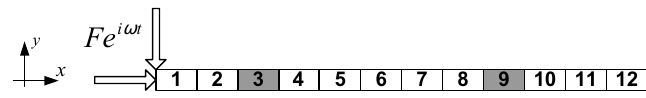
Fig. 1. Beam model excited at the left end by longitudinal and flexural harmonic forces.